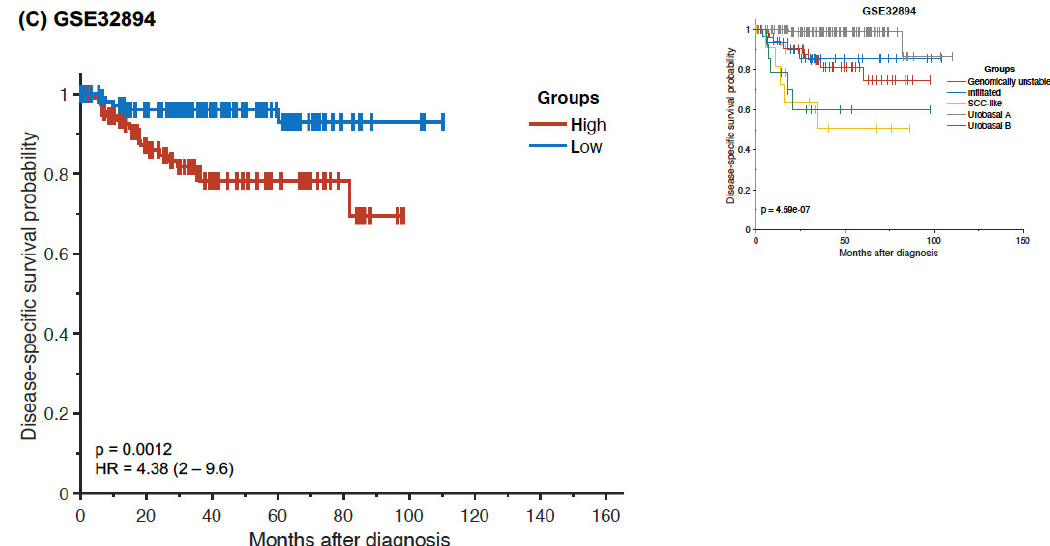
Figure 4. Kaplan–Meier survival curves for high vs. low expression of the combined Oncuria™ signature in ( A ) GSE87304 cohort; insert depicts GSE87304 analyzed by the consensus subtyping system, ( B ) GSE48075 cohort; insert depicts GSE48075 analyzed by the MDA subtyping system and ( C ) GSE32894 cohort; insert depicts GSE32894 analyzed by the model reported in the associated GSE32894 manuscript [18,19,23].